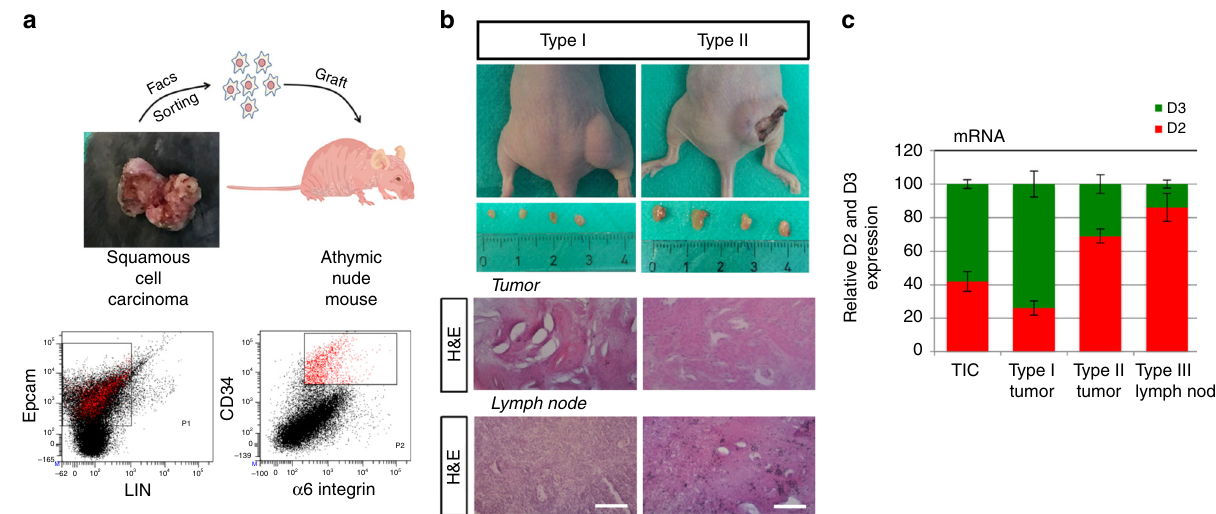
Fig. 4 Tumor xenografts from tumor-initiating cells transplantation dynamically express D2 and D3 during tumor progression. a Schematic representation of the strategy used to isolate and graft TICs from DMBA/TPA tumors ( n = 6). b Representative images of tumors and lymph nodes generated in athymic mice 10 (type I) and 16 (type II) weeks after transplantation (Top). H&E of the tumors and lymph nodes in type I and II mice. Scale bars represent 100 μ m (Bottom). c Relative expression of D2 and D3 in type I and II tumors and in lymph nodes measured by real-time